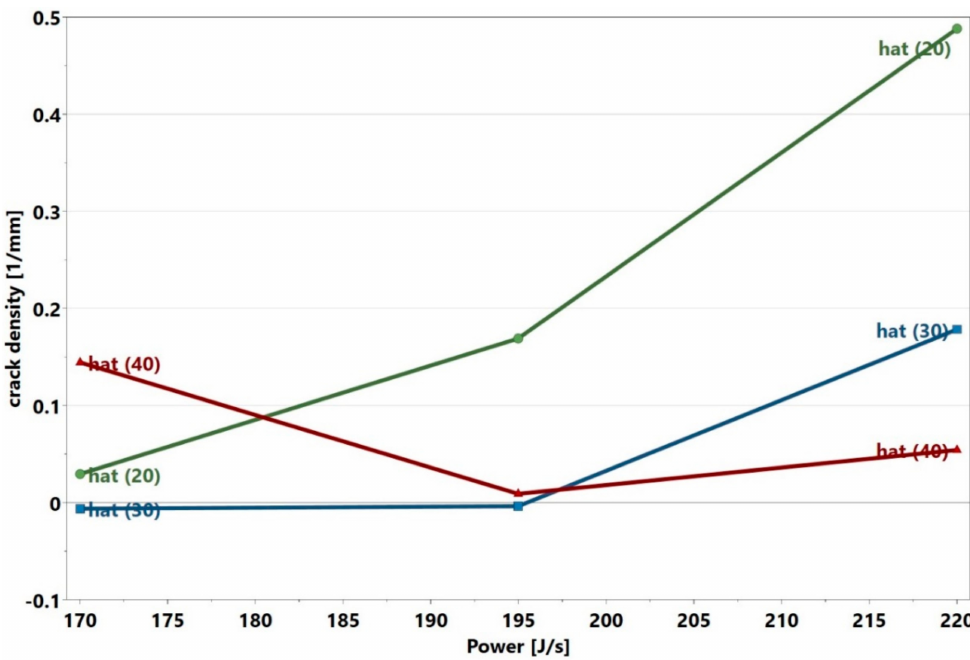
Figure 10. Power and hatch interaction plot.